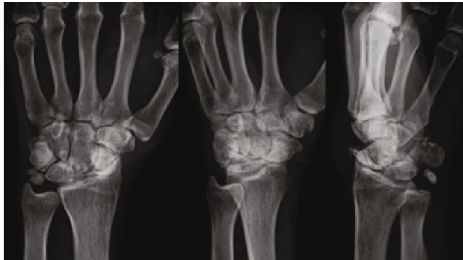
Figure 3: X-ray image obtained immediately after the surgery using the Watson method.